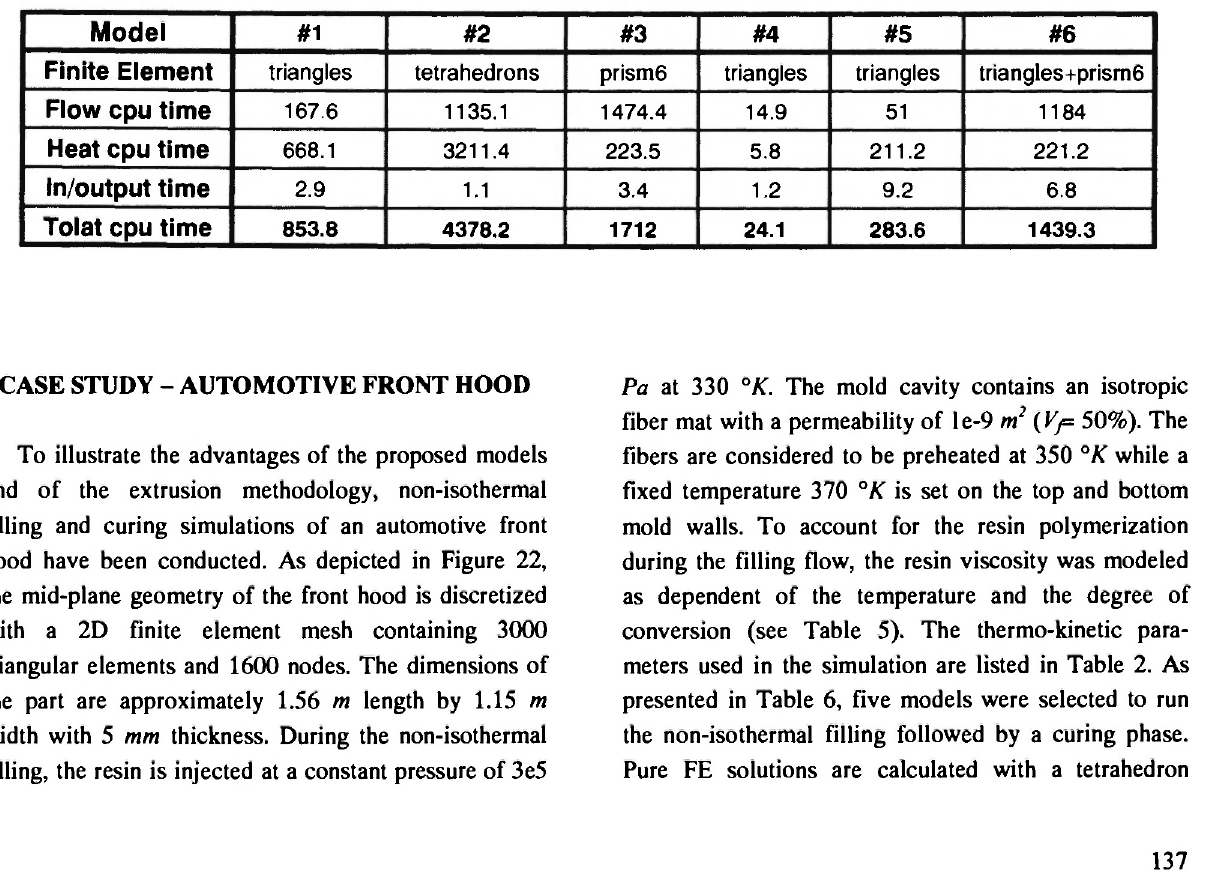
Computer times required to calculate for each solution of test case IV (times are in